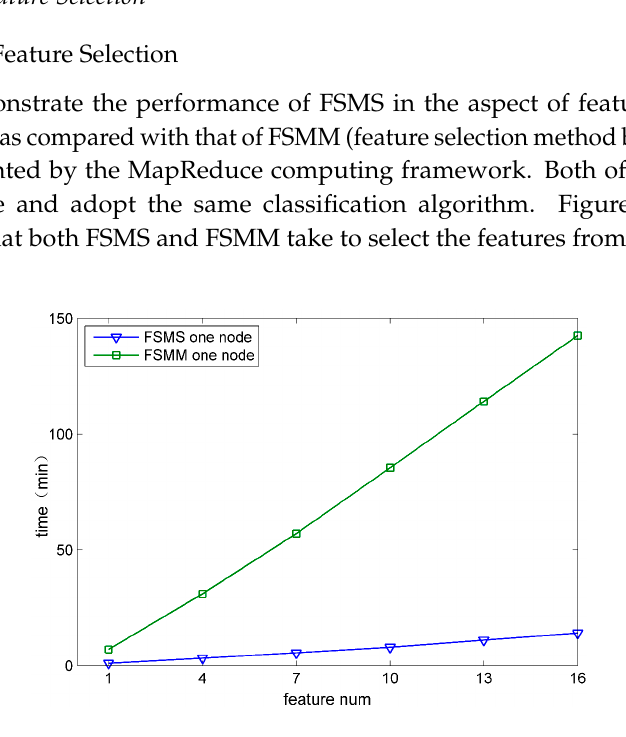
Figure 4. The single node processes Datal.